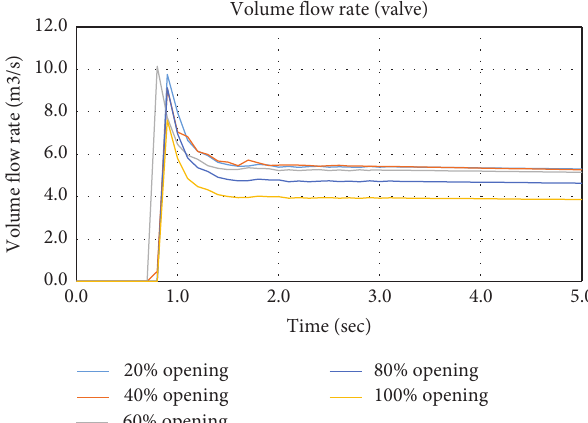
Figure 9: Results of Flow-3D numerical model for the valve’s output flow rate at the service gate’s different openings during model execution.